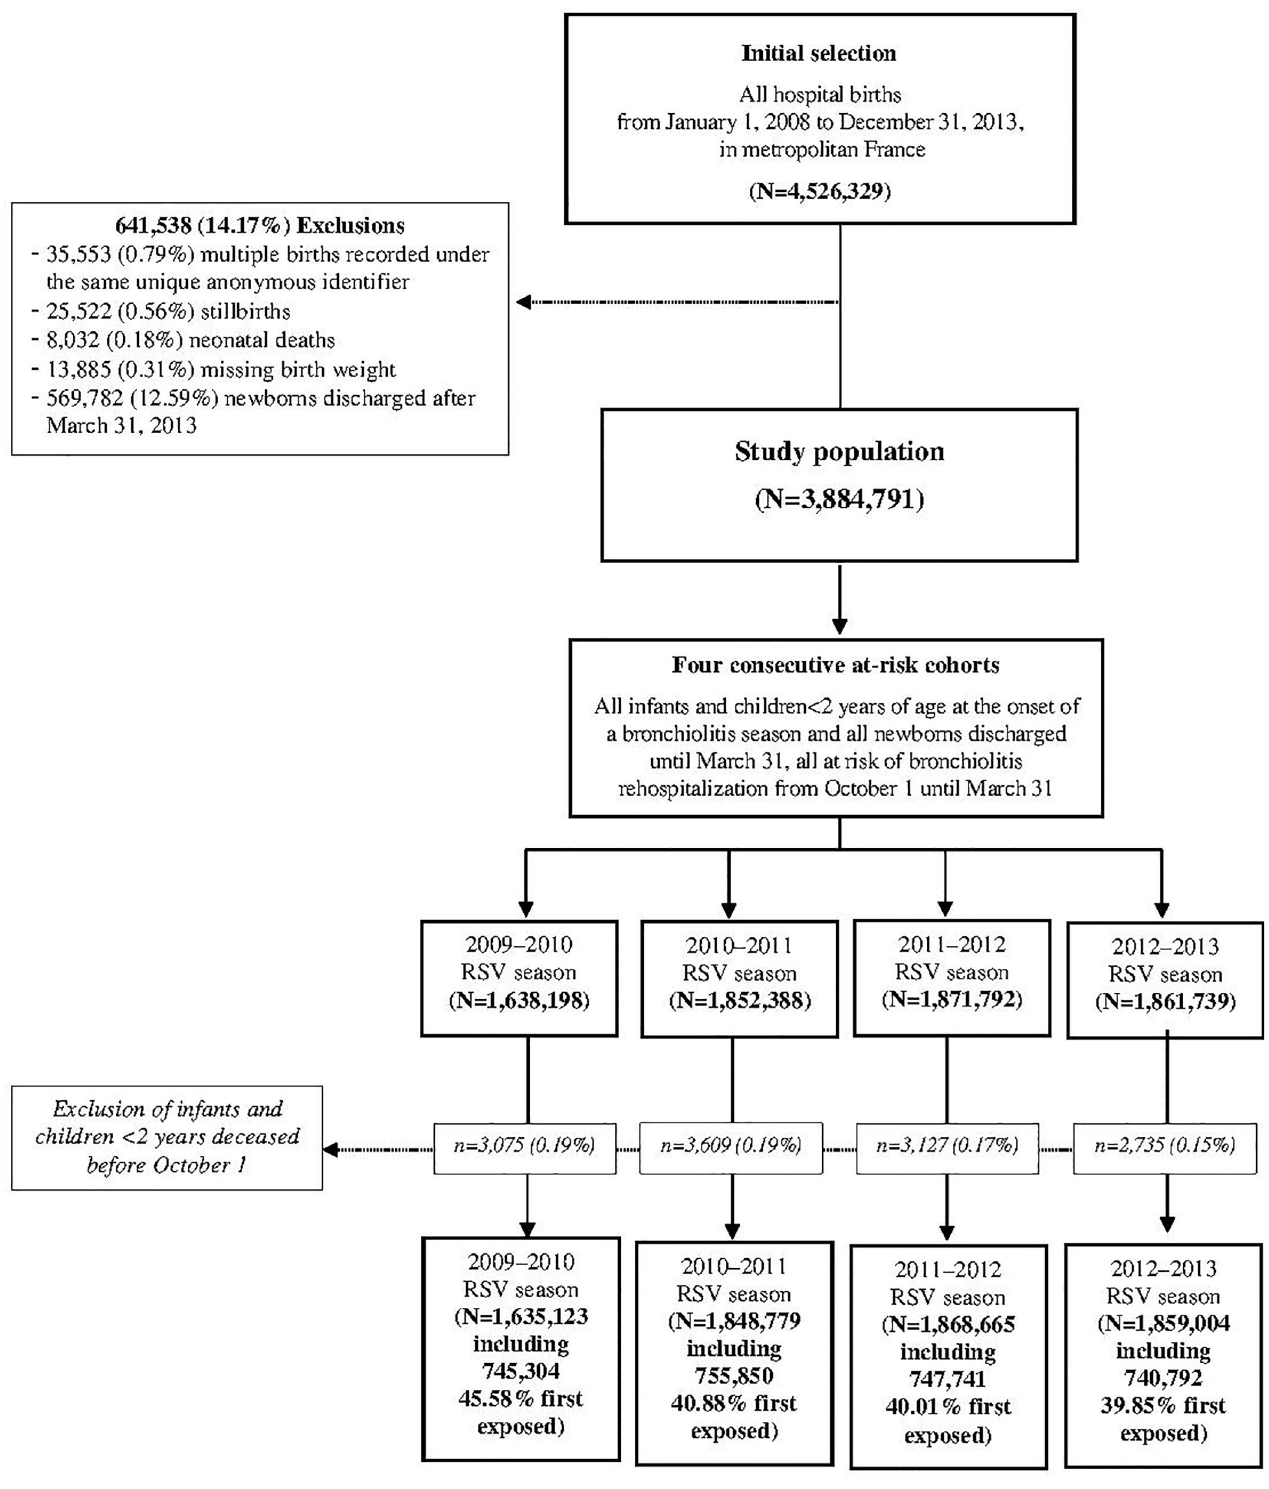
Fig 1. Flow chart of sample selection. Abbreviations: RSV, respiratory syncytial virus.